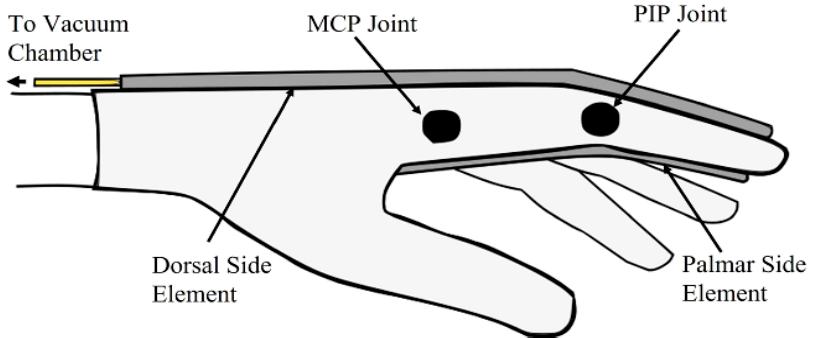
Figure 17. Schematic representation of the jamming elements’ positioning on the tremor suppression glove [125].